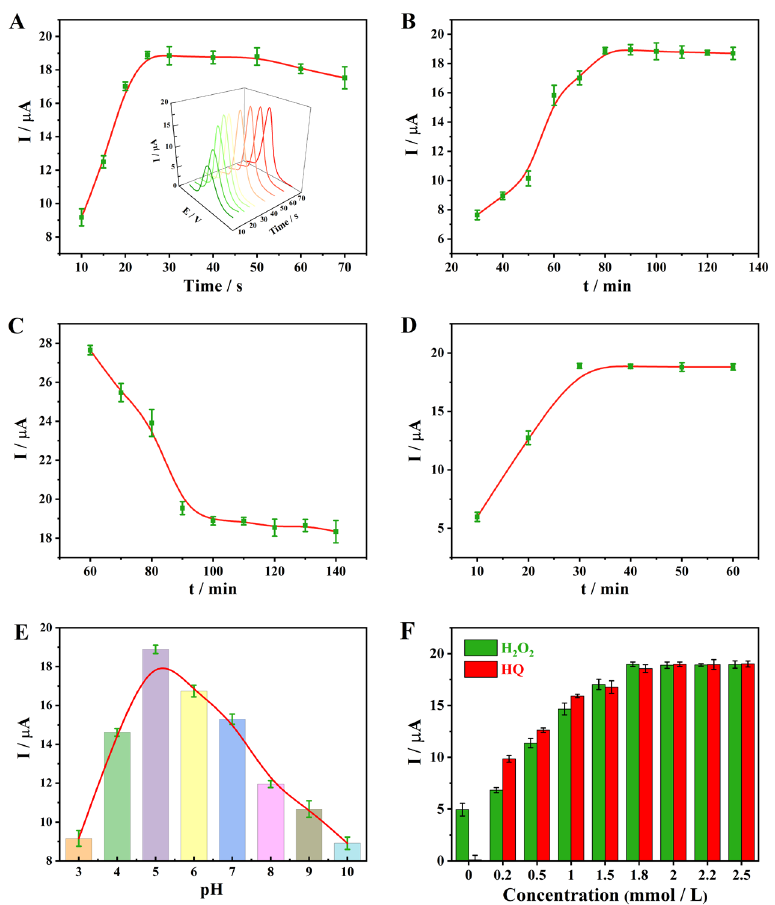
Figure 4. Optimization of experimental conditions: ( A ) deposition time of AuNPs; ( B ) incubation time of cruciform DNA; ( C ) incubation time of cells; ( D ) incubation time of HRP; ( E ) pH optimization; ( F ) concentration of H 2 O 2 and HQ.